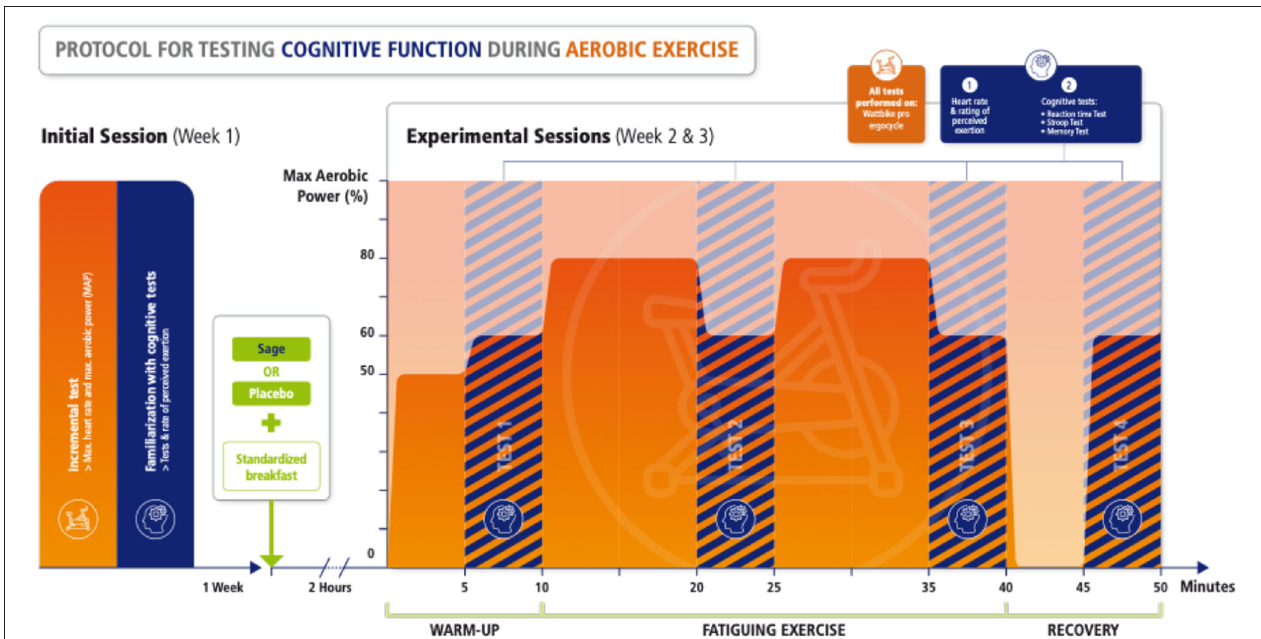
FIGURE 1 | Study flowchart. After a familiarization session (not shown), volunteers performed an initial test session followed by two randomized experimental sessions with SAGE or PLACEBO with 1 week between each session. The experimental sessions were performed on an ergocycle, and cognitive tests were conducted while cycling during the warm-up, during and at the end of the fatiguing exercise and after a short